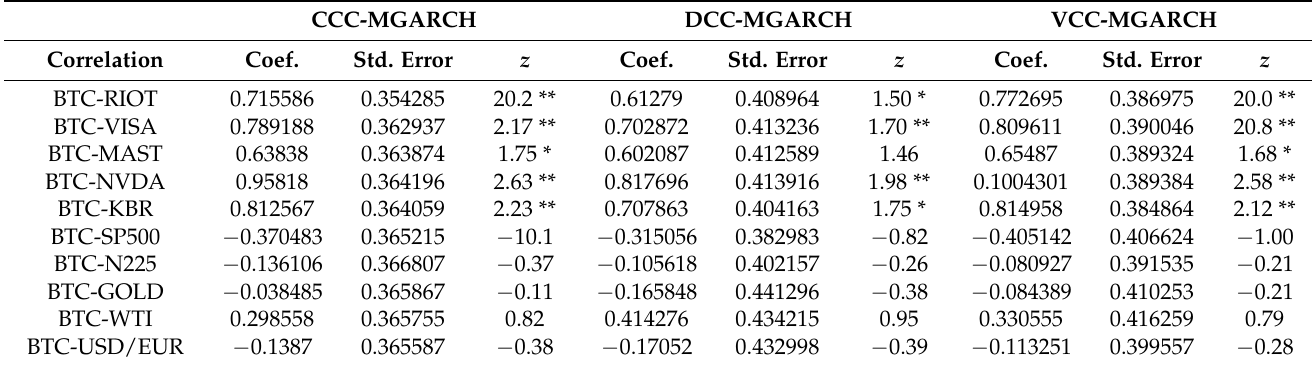
Table 2. Conditional correlations.